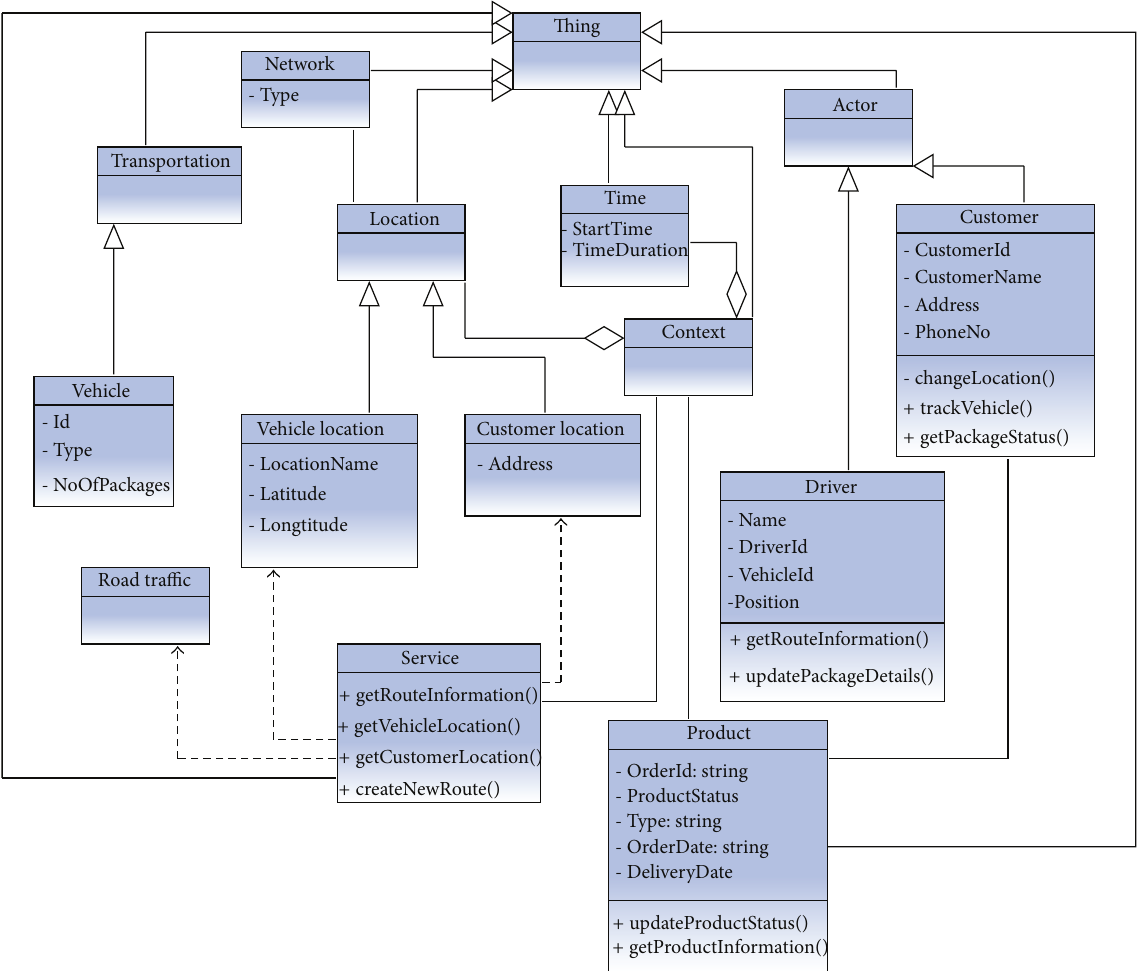
Figure 6: Class diagram of logistics